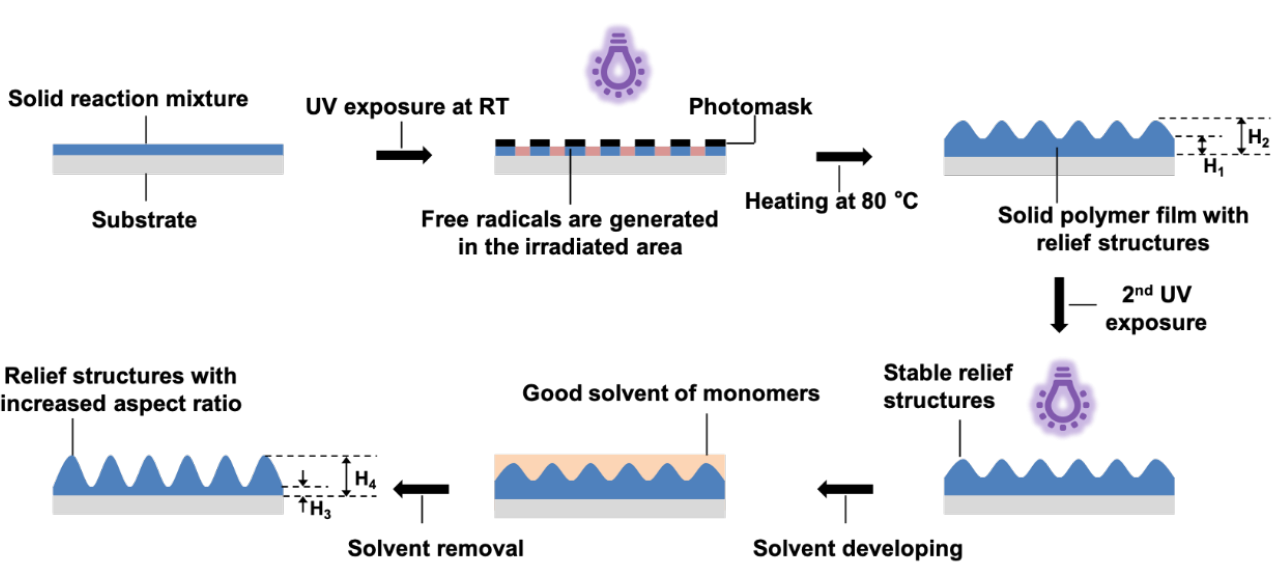
Figure 2. Schematic representation of the photo-embossing process, including the solvent developing step. RT stands for room temperature.